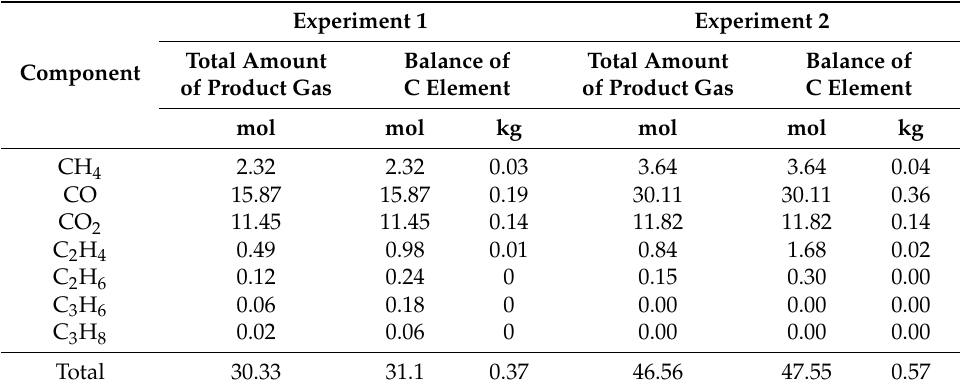
Table 3. Calculation of C balance (0.5~3.0 h for experiment 1, 0.5~1.5 h for experiment 2).